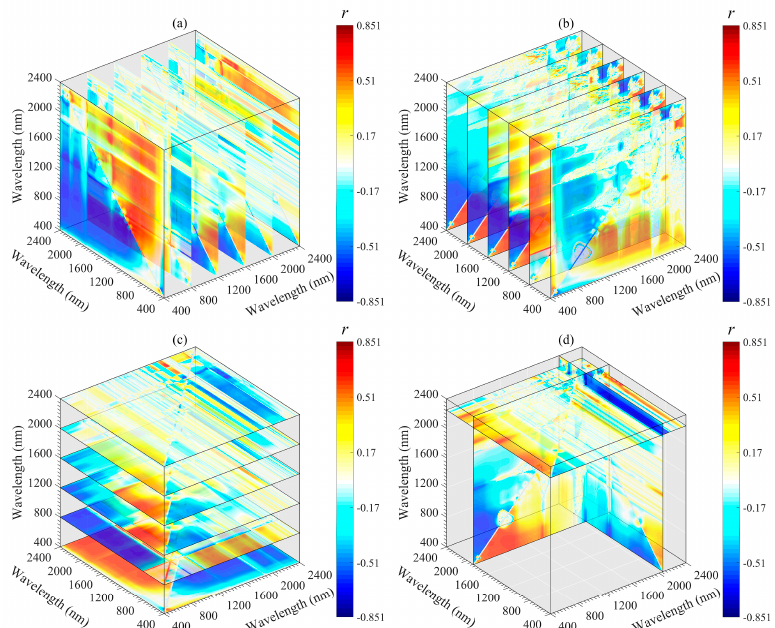
Figure 7. Three-dimensional slice maps of correlations between SOM content and TBI2 based on the calibration set ( n = 112). ( a ), ( b ), and ( c ) represent slice maps based on the x -axis, y -axis, and z -axis, respectively, and ( d ) represents the optimal slice map.